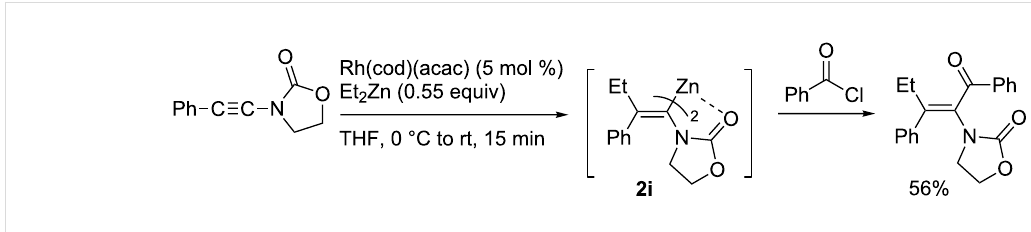
Scheme 14: Rhodium-catalyzed carbozincation of ynamides.